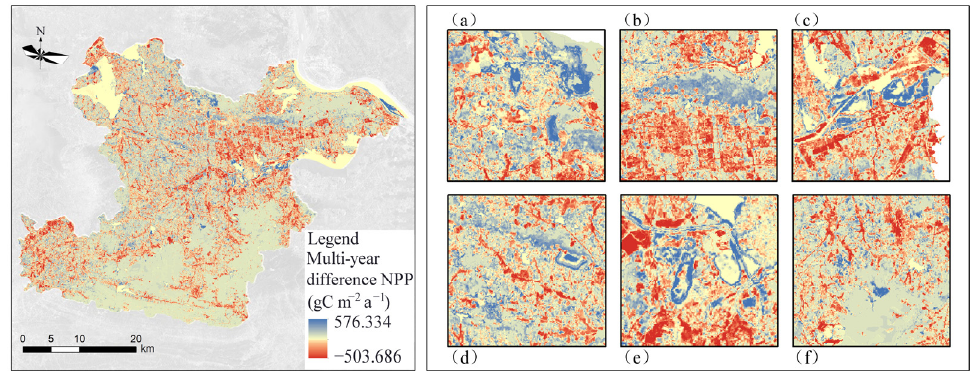
Figure 3. Distribution of NPP difference in Huangshi City from 1990 to 2018: ( a ) Tieshan-Huidiqiao mining area, ( b ) Huangjingshan mining area, ( c ) Sanli Qihu wetland, ( d ) Jinshandianzhen mining area, ( e ) Tonglushan mining area, and ( f ) Dajipu mining area.